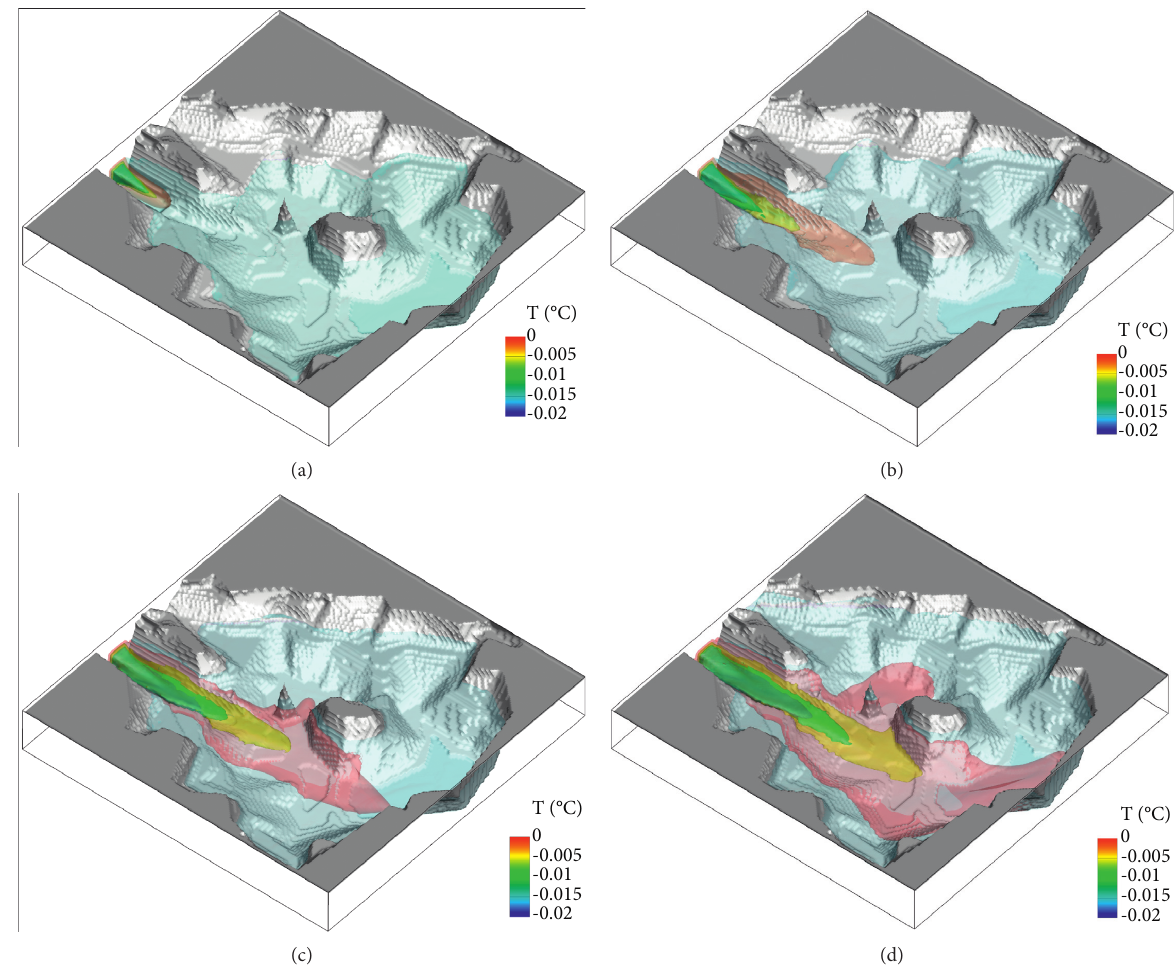
Figure 14: Isothermal surface distribution of an upper reservoir: (a) t � 71min, (b) t � 75min, (c) t � 85min, and (d) t �